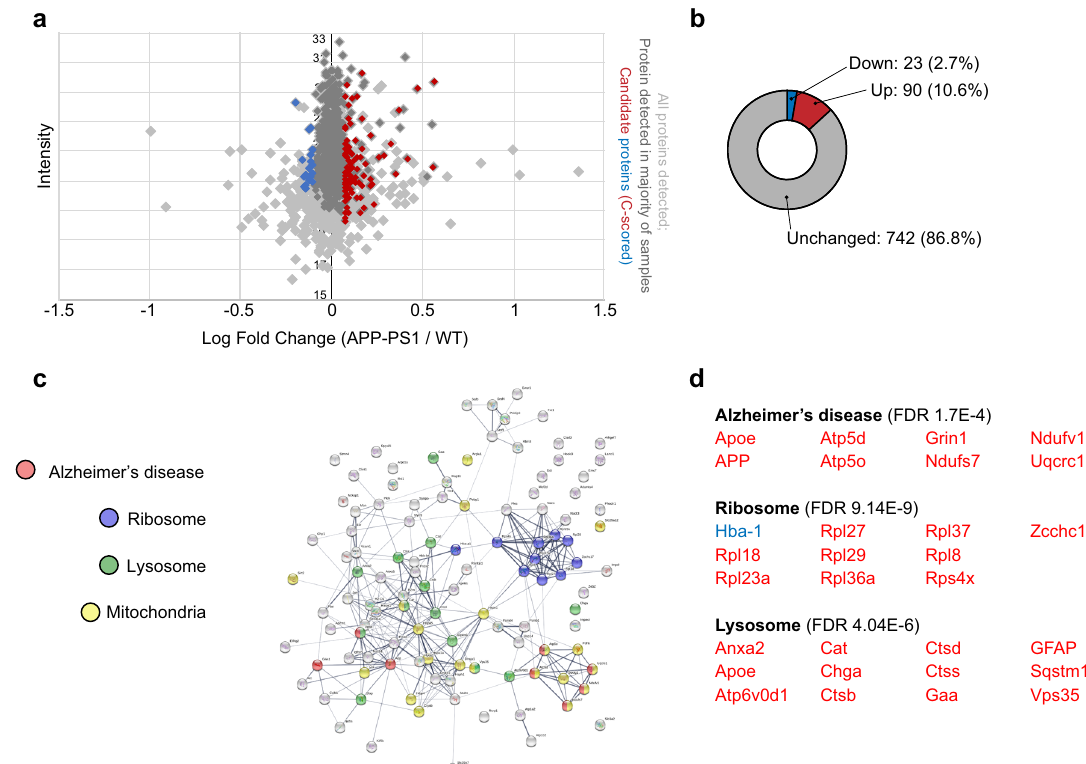
Fig. 3 Analysis of altered de novo proteome highlights impaired proteostasis in aged APP/PS1 mice. a Fold change vs. intensity distribution plot showing all proteins detected in 12 + -month-old APP/PS1 mouse hippocampal slices vs. wild-type (WT) littermates using BONLAC (light grey). Dark grey overlay depicts proteins that were consistently detected in the majority of samples (>4 out of 7 biologically independent samples), and candidate proteins identi fi ed by C-score screen as upregulated (fold change ≥ 1.2) shown in red, while downregulated proteins ( ≤ 0.8) are labelled blue. b Doughnut plot indicating the majority of proteins detected in 12 + -month-old mice are not altered in APP/PS1 mice (742; 86.8% of proteins detected). 23 proteins are downregulated compared to WT mice (2.7% of proteins show a fold change > 0.8, blue) and 90 proteins are upregulated in APP/PS1 mice (10.6% of proteins show a fold change < 1.2, red). c String diagram showing enriched gene ontology networks. d DAVID-identi fi ed functional clusters in 12 + -month- old APP/PS1 mice. Red = upregulated proteins. Blue = downregulated